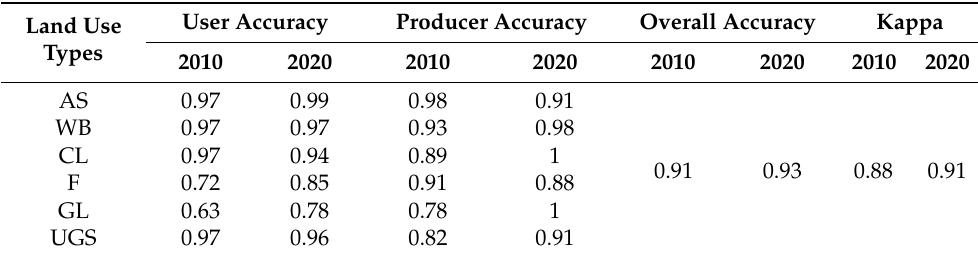
Table 7. Land use classification accuracy for 2010 and